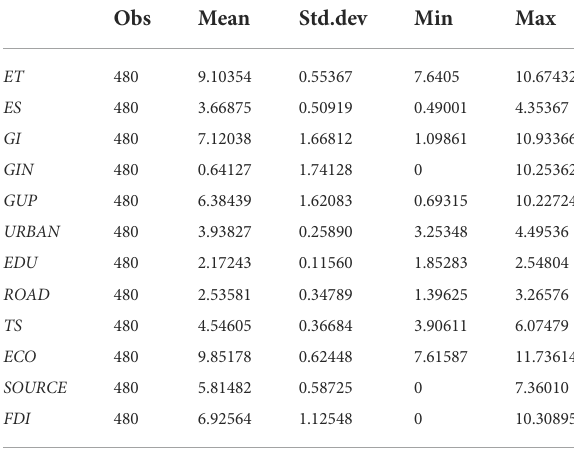
TABLE 1 Statistical despcription of